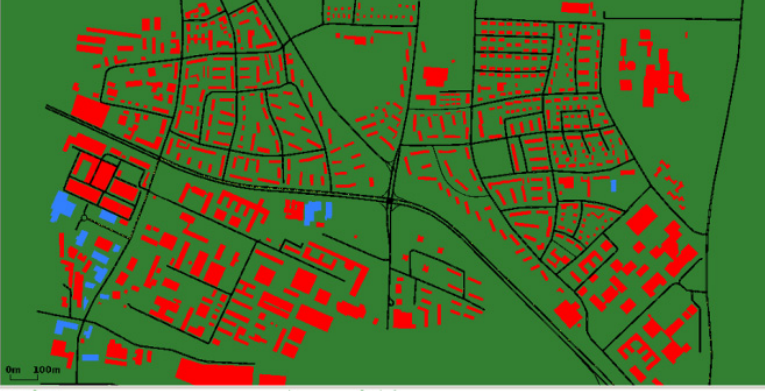
Figure 6. View of Erlangen map in SUMO.